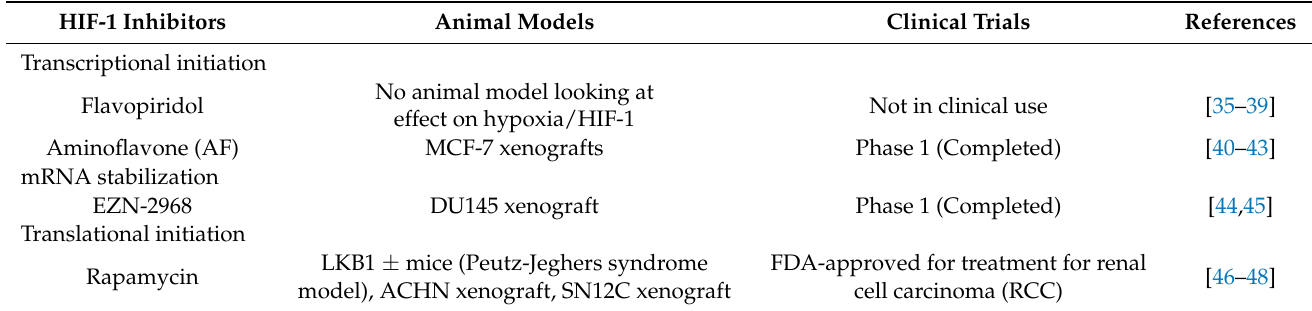
Table 2. Potential HIF-1 inhibitors under